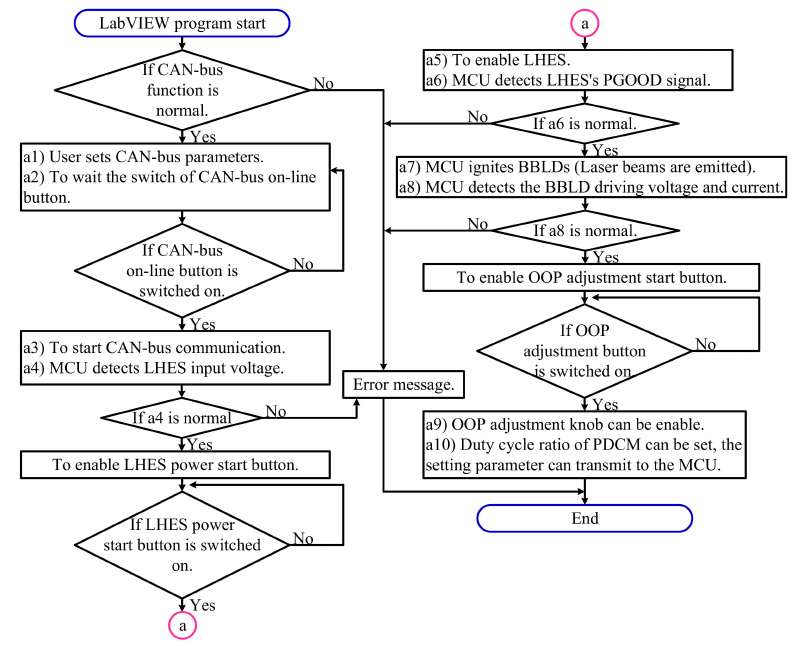
Figure 5. Software flowchart of LabVIEW for human–machine